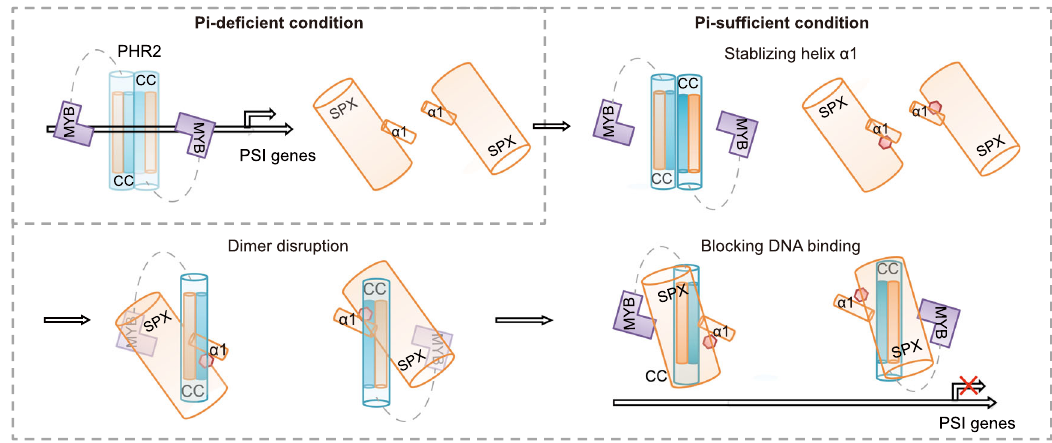
Fig. 6 InsP 6 -induced and SPX1-mediated PHR2 dimer dissociation and DNA binding inhibition. A proposed model for InsP molecule induced recognition and inhibition of PHR2 by SPX1. Under Pi-de fi cient condition, PHR2 existed as a dimer to bind to the P1BS, and activated the transcription of PSI genes. Under Pi-suf fi cient condition, InsP molecule could be recognized by SPX1 and stabilized the helix α 1 of SPX1 with InsP molecule concentration increasing. Then, PHR2 dimer was disrupted, allowing SPX1 interacted with MYB and CC domains of PHR2 simultaneously. Thus, the transcriptional activation of PSI genes was repressed. The red octagon in the model represented InsP